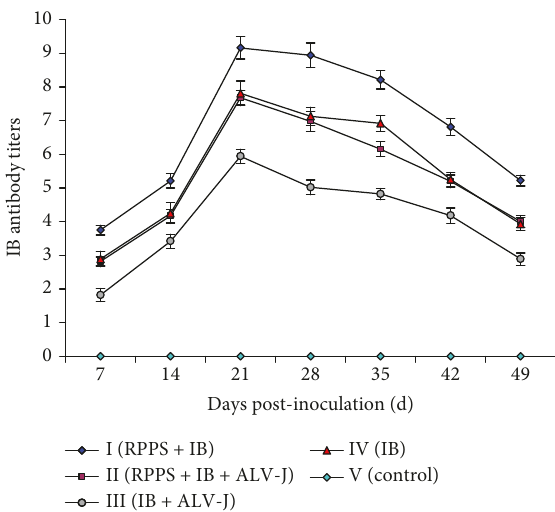
Figure 1: Changes of antibody titer in the